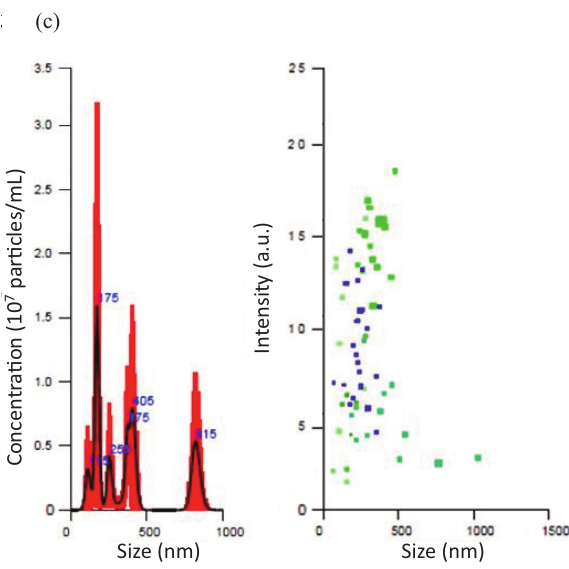
! Particle size (nm) and distribution at [CaS] = 0.097 ± 0.01 mM (pH = 9.94 ± 0.02), the average concentration of CaS particles is 1.35 ± 0.57·10 6 per mL.